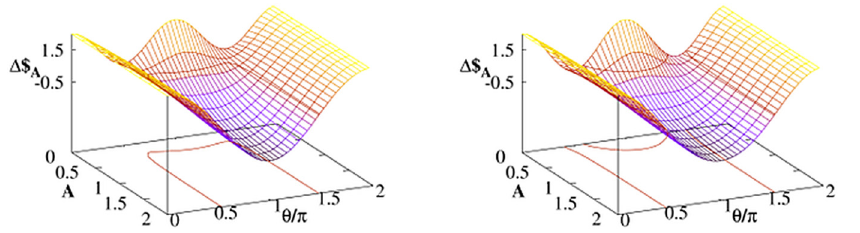
Fig 3. Payoff differences Eq (29) as a function of A calculated at time t = 2 for Alice – Bob strategy profiles ( I , I U ) (left panel) and ( I , F U ) (right panel) with the quantum strategy Eq (12) with U = U ( π /2,0, π /2). The thermal Davies environment (with G = 1) influences only one player (either Bob or Alice) and p = 0.